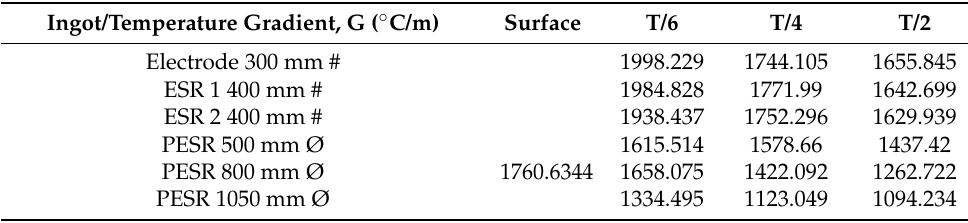
Table 6. Temperature gradient ( ◦ C/mm) and distance from surface (mm) for